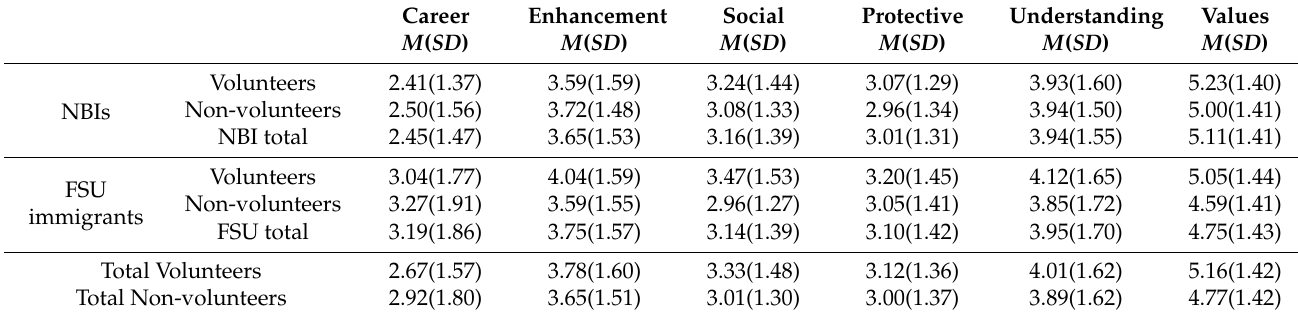
Table 3. Motivation for volunteerism according to origin and actual volunteer activity ( N =